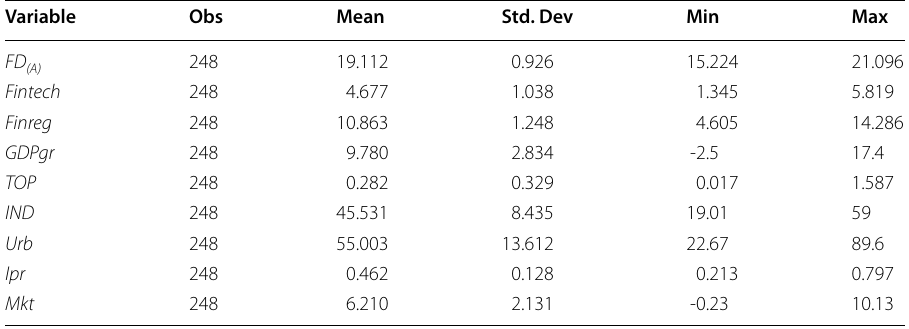
Table 9 Provincial data summary statistics